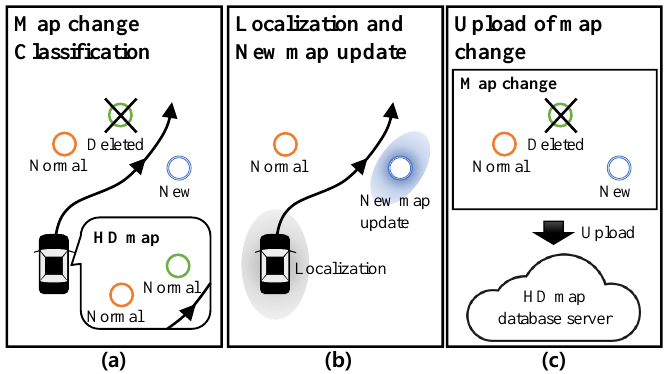
Figure 3. Process of the map change update. The first step is map change classification, the second step is the utilization the HD map and the updating the new map features, and final step is the upload to HD map database